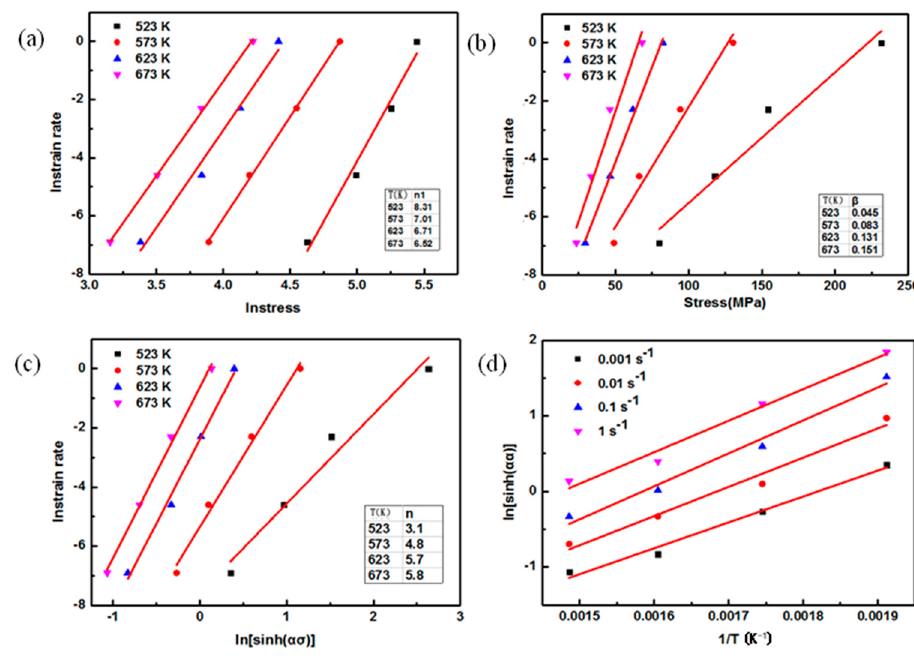
. ε − . ε − σ . ε − ln σ ; ( b ) ln ; ( c ) ln (sinh( ασ ));